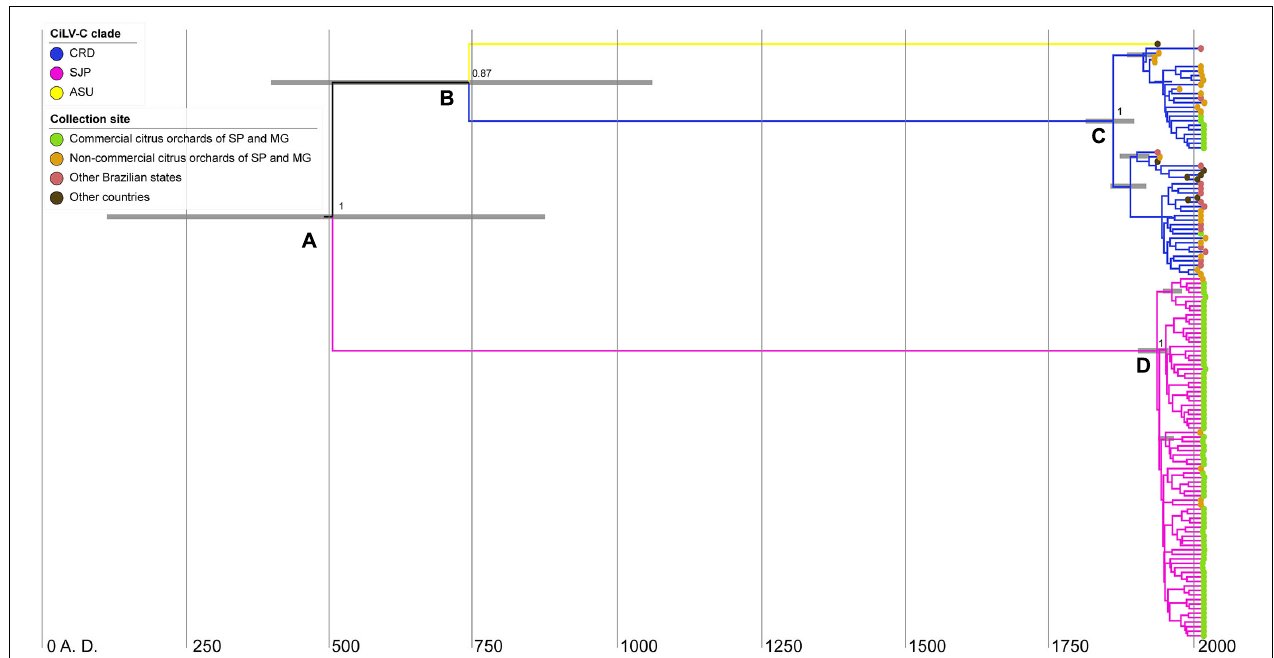
FIGURE 6 | Bayesian maximum-clade-credibility time-scaled phylogenetic tree using the concatenated sequences of the p29 (795 nts) and p32 (288 nts, partial) ORFs from 132 CiLV-C isolates collected in the period 1932–2020 in South America. Horizontal gray bars on nodes (A–D) indicate the uncertainty for the date of each node (95% highest posterior density—HPD—intervals). Figures near the main nodes represent the posterior probability values. The phylogenetic tree was edited using